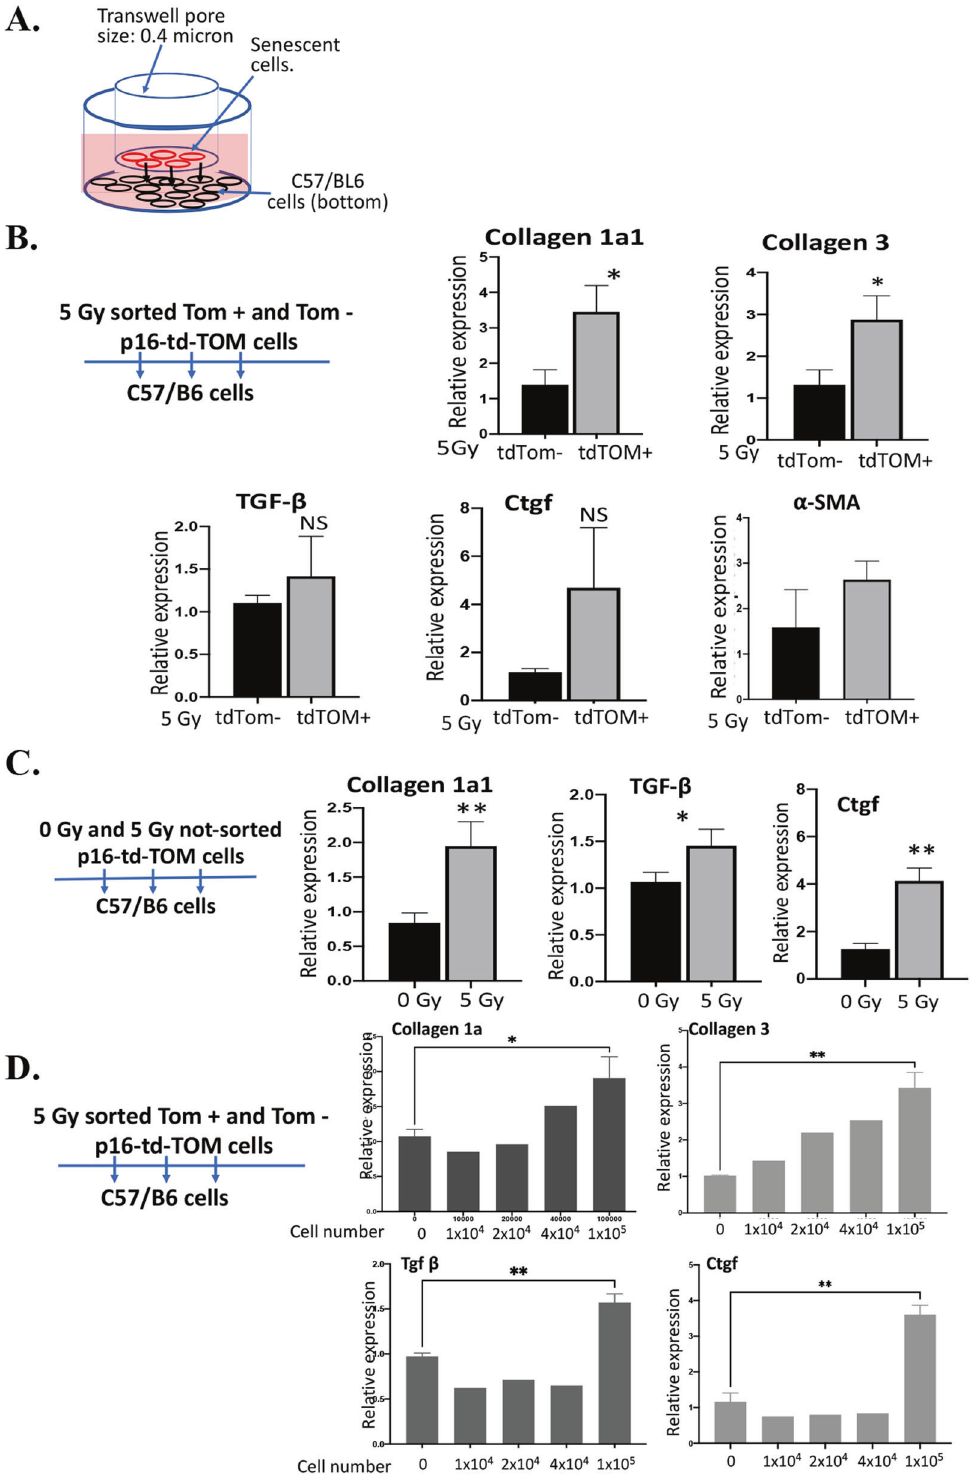
Fig. 4 Senescent tdTOMp16 + cells induce biomarkers of fi brosis in target cells. Scheme of non-contact transwell coculture system. The top well and the bottom well were: A separated by 0.4-micron fi lter. B Irradiated tdTOMp16 + senescent (tdTOM + ) and non-senescent (tdTOM − ) cells were cultured on top well and the target C57BL/6 stromal cells were cultured on the bottom well. After 10 days, target cells were harvested for RNA and RT-qPCR was performed for Collagen1a1, Collagen 3, and TGF- β , CTGF, and α -smooth muscle actin ( α -SMA) genes. C Irradiated (5 Gy) and non-irradiated (0 Gy) tdTOMp16 + cells were cultured on top well and the target C57BL/6 stromal cells were cultured on the bottom well. After 10 days, target cells were harvested for RNA, and RT-qPCR for Collagen1a1, TGF- β , and CTGF genes were performed. D Increasing number of senescent tdTOMp16 + cells (0, 1 × 10 4 , 2 × 10 4 , 4 × 10 4 , and 1 × 10 5 cells) were plated on top well and the target C57BL/6 stromal cells were cultured on the bottom well. After 10 days, target cells were harvested for RNA and RT-qPCR for Collagen1a1, Collagen 3, TGF- β , and CTGF genes was performed ( n = 3, * P = <0.05; ** P = 0.01, NS = non-signi fi cant). P values were calculated by t test. Cell Death Discovery (2021)